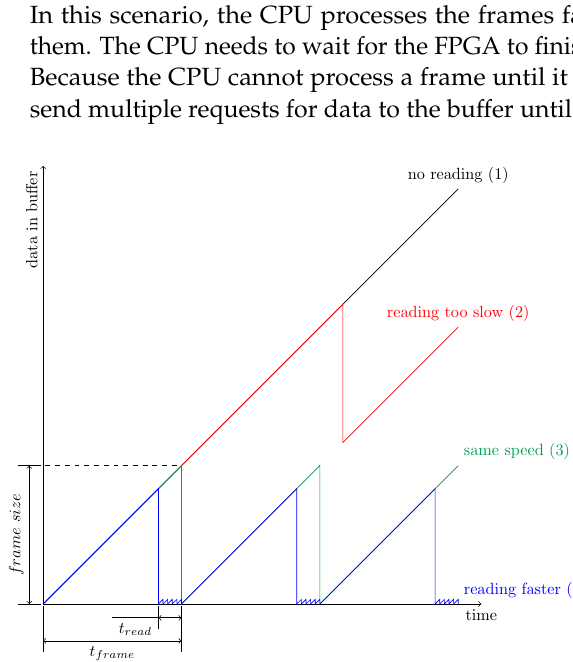
Figure 11. Data in the buffer for four different situations. ( 1 ): no data is read from the buffer and everything remains in the buffer. ( 2 ): data is read from the buffer, but at a slower rate than that it is stored. ( 3 ): Data is read from the buffer at the same speed it is stored. Every time one frame is ready in the buffer, it is read, resulting in an empty buffer. ( 4 ): A request for data is performed at a higher rate than that the data is stored in the